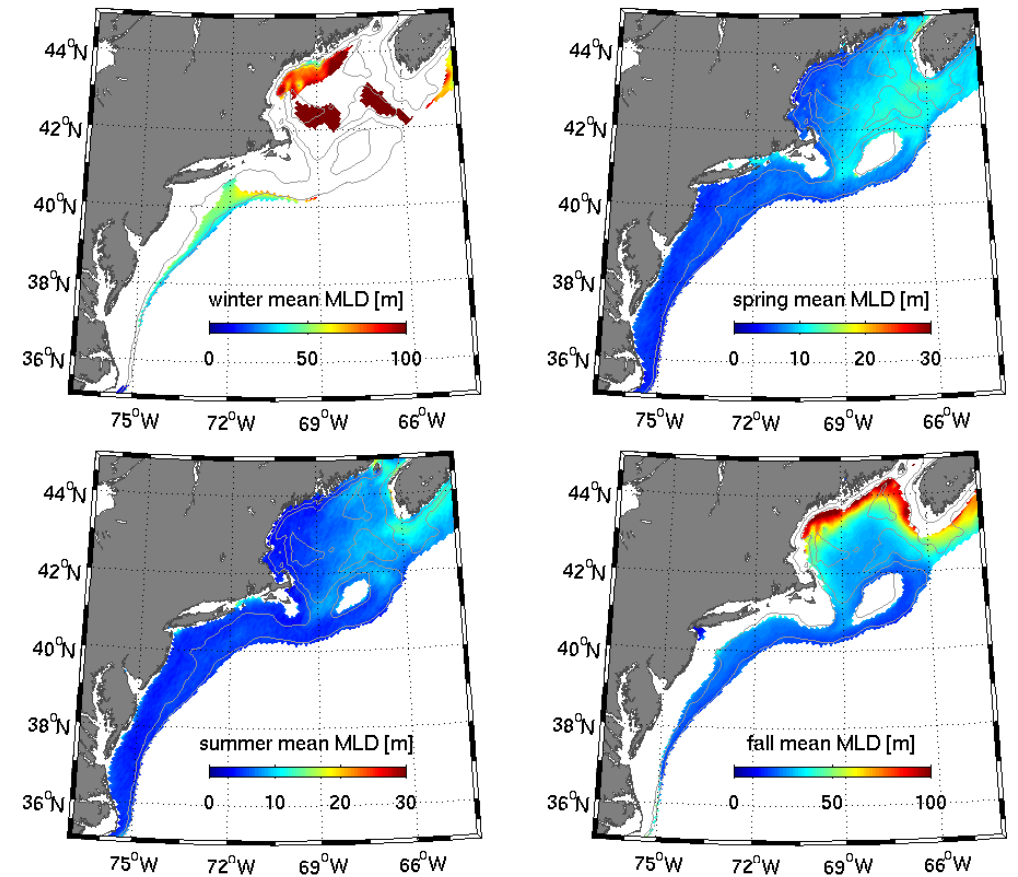
Figure 10. Simulated seasonal mean mixed layer depth (m) over the continental shelf (<200m) in the MABGOM domain. Four seasons are defined as follows: January–March (winter), April–June (spring), July–September (summer), October–December (fall). 50, 100, and 200m isobaths are